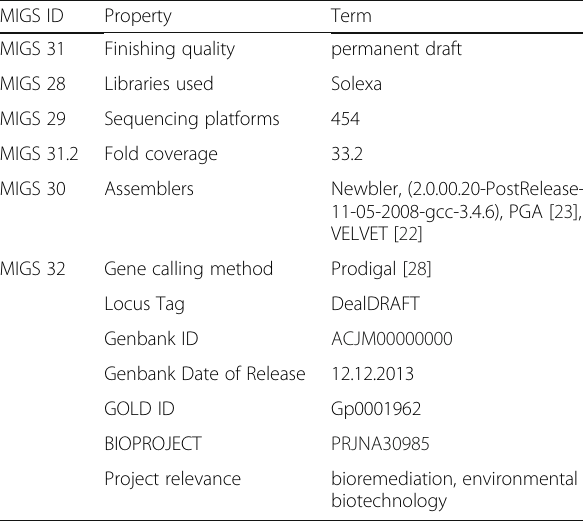
Table 2 Project information Table 3 Nucleotide content and gene count levels of